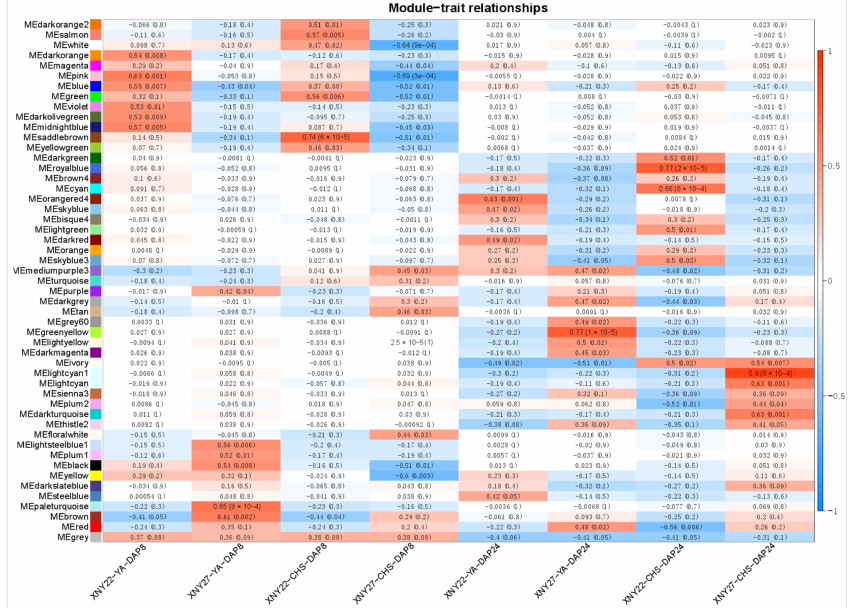
Figure 5. The correlation coefficient and correlation significance between the module and different kernel developmental stage hybrid of Cd stress. Each row in the table corresponds to a consensus module, and each column to different location, kernel developmental stage, and hybrid. The module name is shown on the y -axis, and the time point is shown on the x